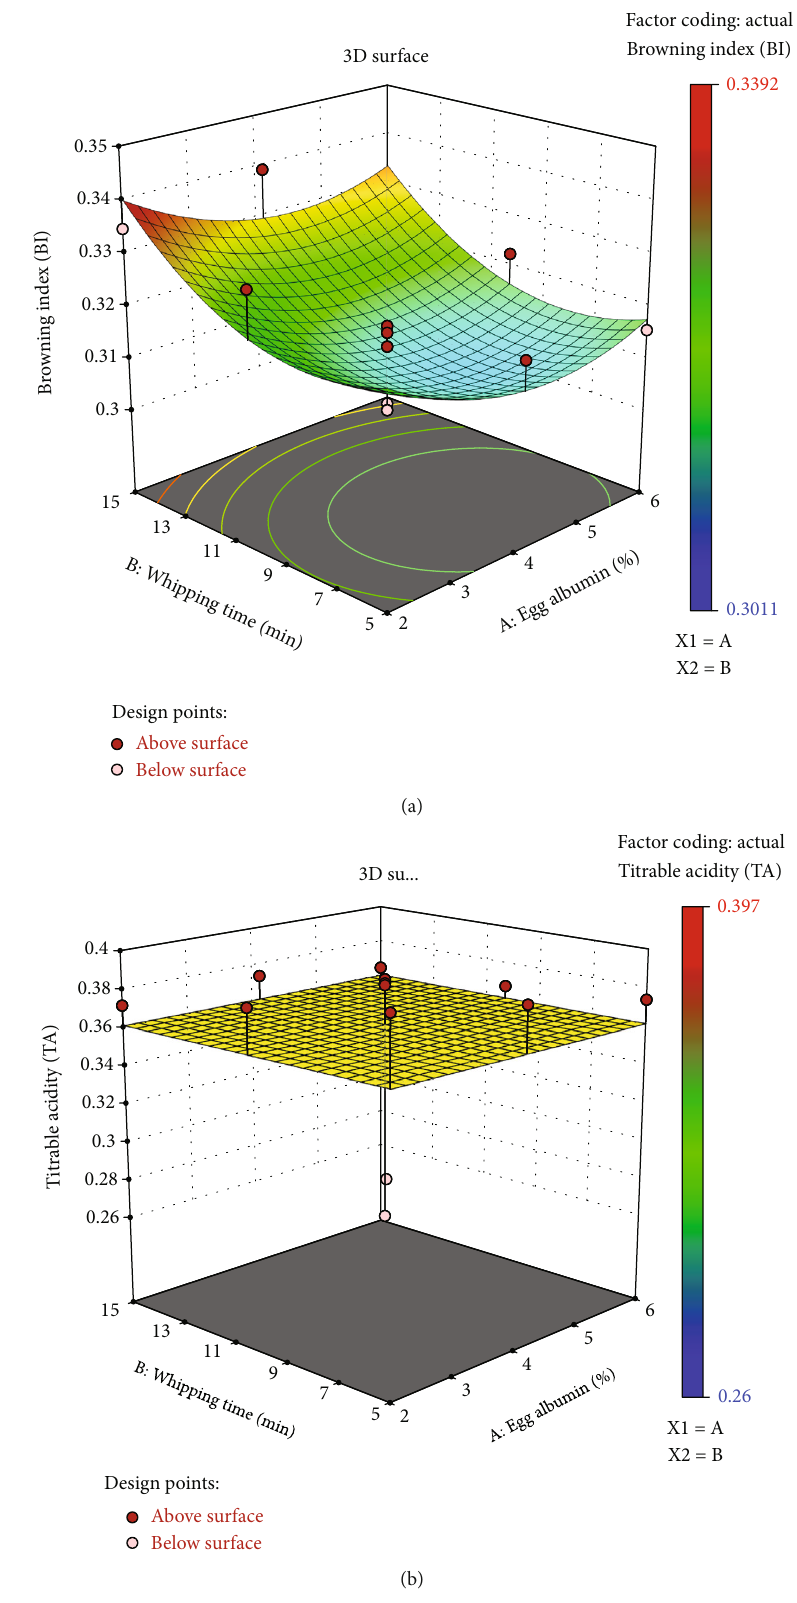
Figure 5: The combined impact of egg albumin and whipping time on BI (a) and TA (b) is depicted by a response surface